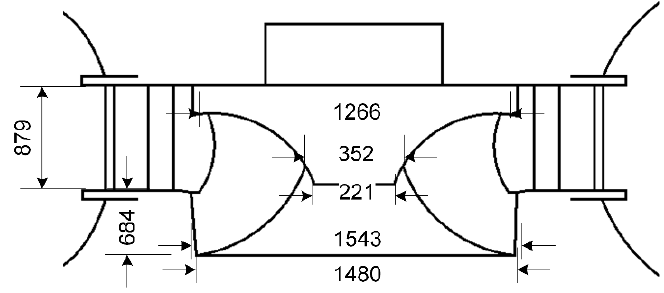
Figure 18. Dimensions of the runner (mm).